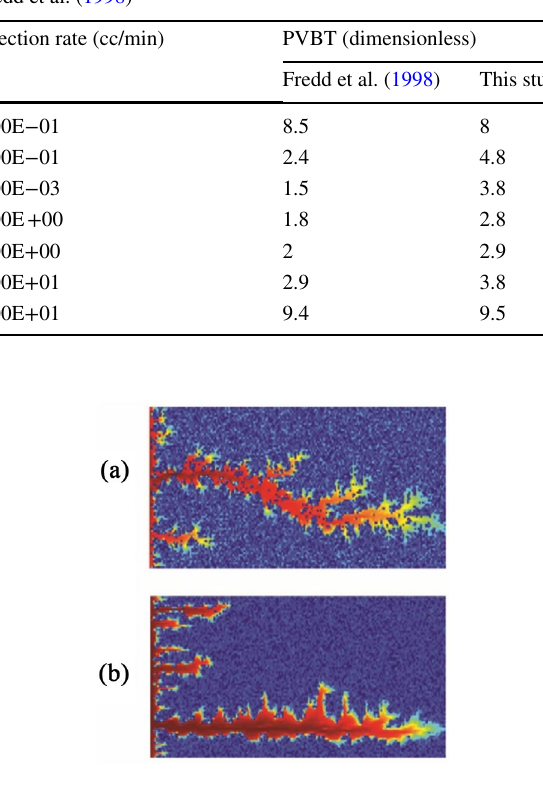
Fig. 7 Wormhole propagation pattern at a 70 °F and b 150 °F